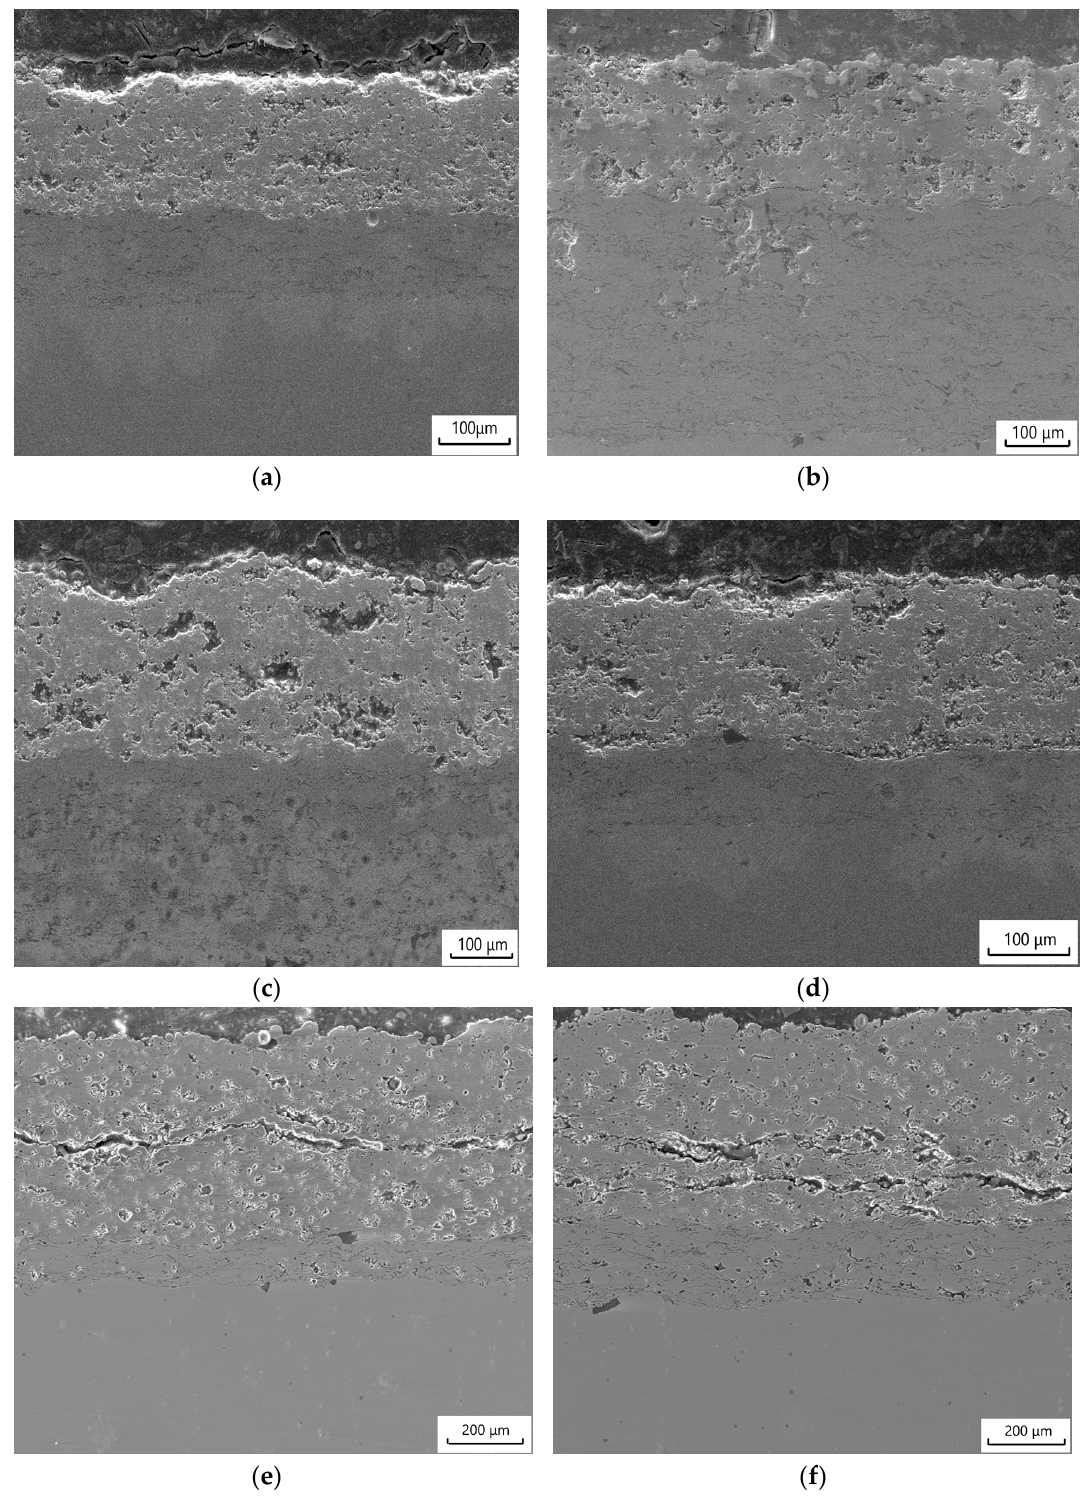
Figure 11. The cross-section morphology of the top coats in TBCs with 0% pore former added at 1100 °C for different serving times: ( a ) 1 day; ( b ) 10 days; ( c ) 20 days; ( d ) 30 days; (e ) 60 days; ( f ) 90 days.